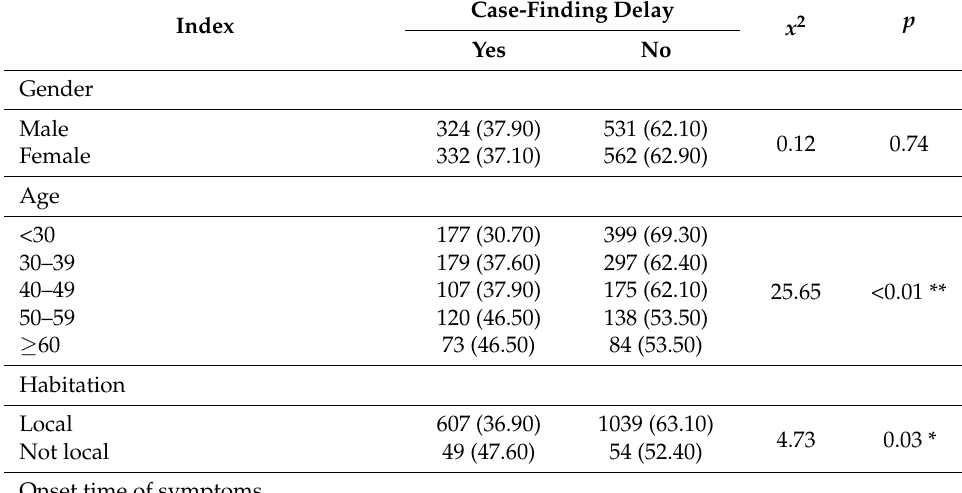
Table 1. Univariate analysis of case-finding delays among full-time teachers with TB.